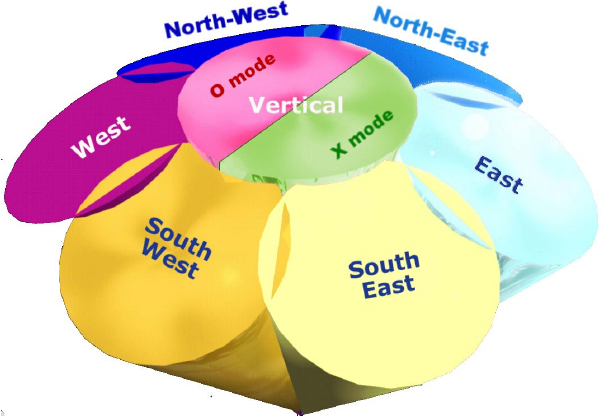
Fig. 6. Seven digitally synthesized beams for ionograms measure- Figure 6. Seven digitally synthesized beams for ionograms measurements.